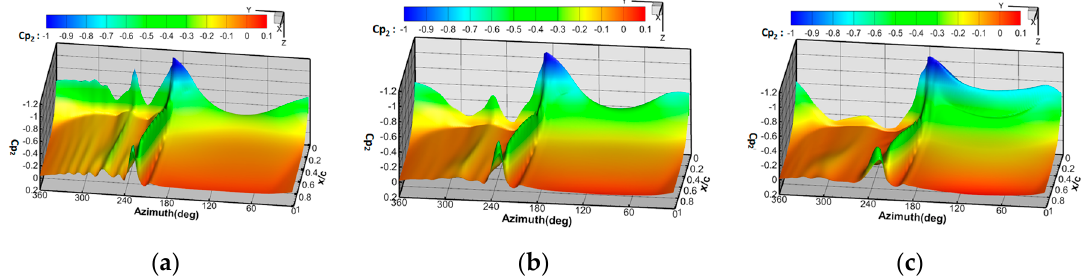
Figure 11. Comparisons of pressure coefficient at different oscillating velocities (k=0.075, α = 12.0 ◦ + 8.0 ◦ sin ( ω t + π ) ). ( a ) λ = 0.0. ( b ) λ = 0.25. ( c ) λ = 0.5.